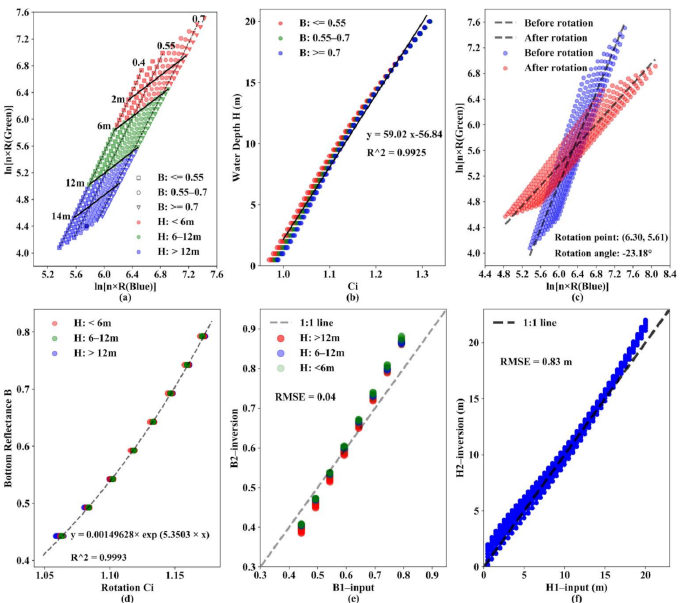
Figure A2. The Hydrolight simulation result at 0.1 mg/m 3 of Chl-a. ( a ) Hydrolight simulation reflectance of blue–green bands. Different colors represent different water depths, and different shapes represent different bottom reflectance. Black straight lines represent the water depth contours, and black dotted lines represent the bottom reflectance contours. ( b ) Fitting curve of C i and the corresponding water depth, H . ( c ) Scattered points in ( a ) before and after a clockwise rotation of 23.18 ◦ (–23.18 ◦ ) to C (cid:48) , where the best correlation with bottom reflectance occurs. ( d ) Exponential fitting i curve of C (cid:48) and bottom reflectance, B . ( e ) Fitting curve of the inversion result B2 and Hydrolight i input value B1 . ( f ) Fitting curve of the inversion result H2 and Hydrolight input value H1 .